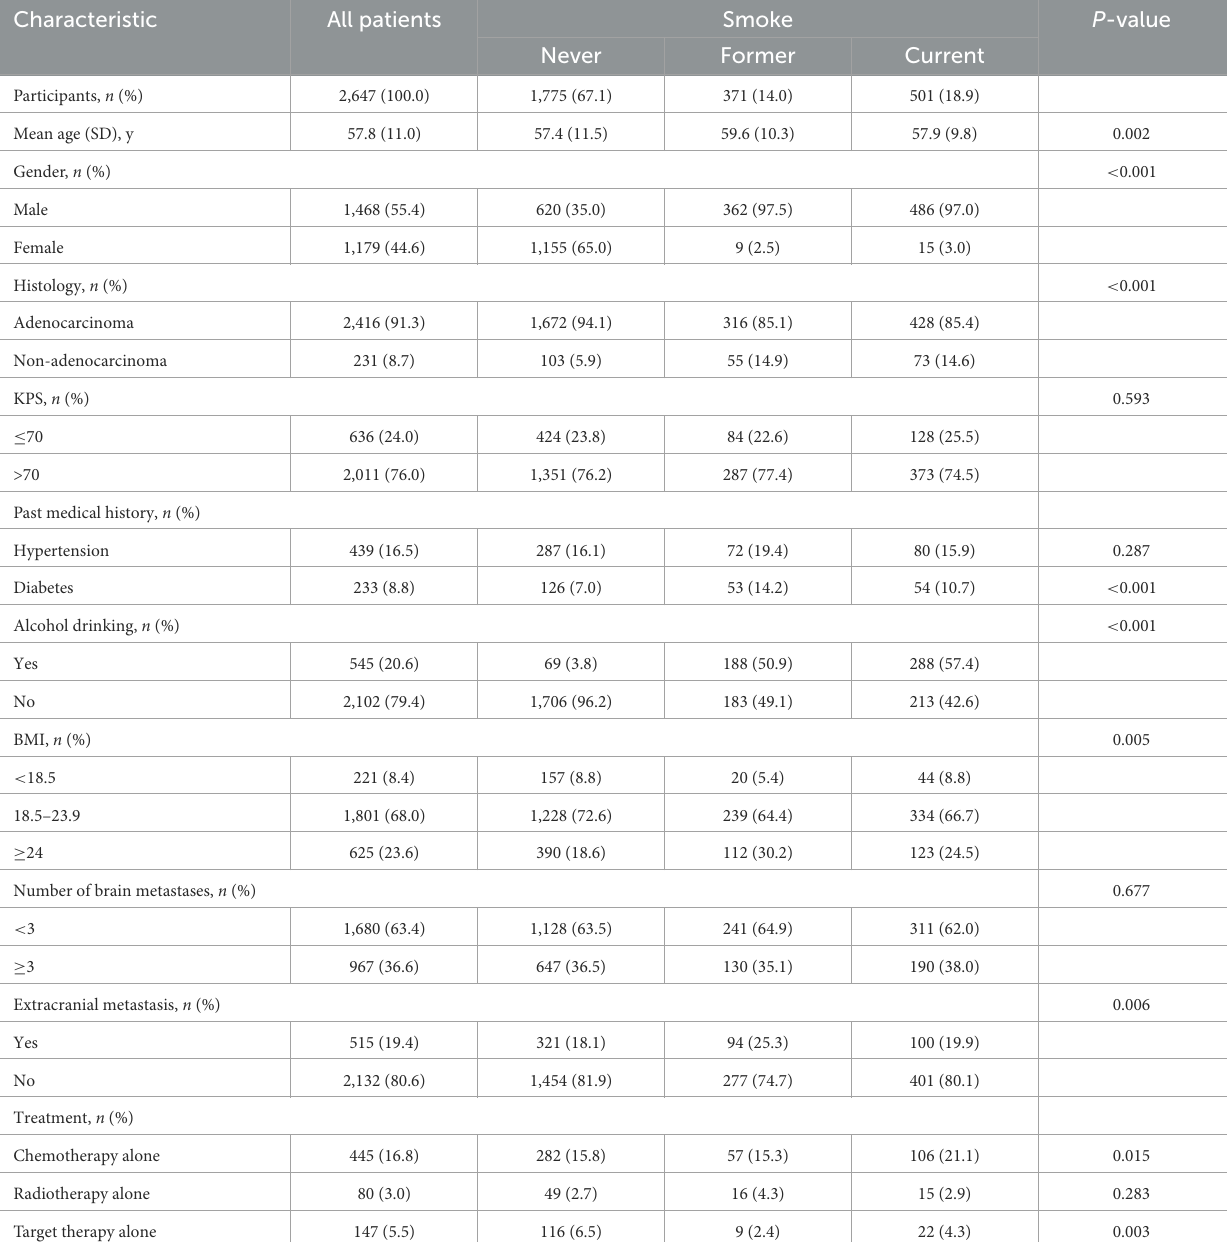
TABLE 1 Clinical and smoking characteristics of lung cancer patients with brain metastases. Characteristic All patients Smoke P -value Never Former